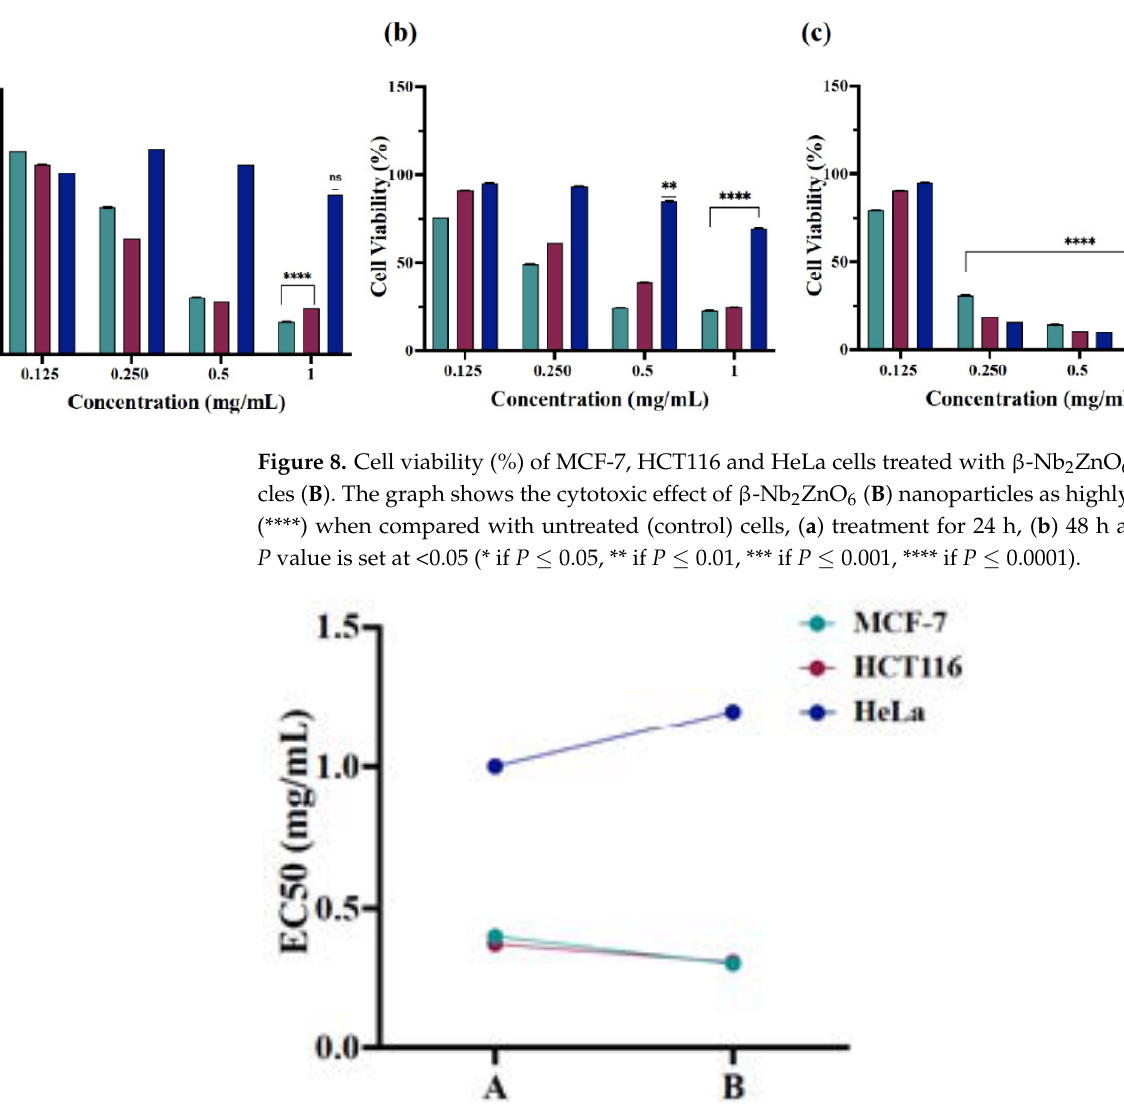
Figure 7. Cell viability (%) of MCF- 7, HCT116 and HeLa cells treated with β -Nb 2 ZnO 6 nanoparti- cles ( A ). The graph shows the cytotoxic effect of β -Nb 2 ZnO 6 nanoparticles ( A ) as highly significant (****) when compared with untreated (control) cells, ( a ) treatment for 24 h, ( b ) 48 h and ( c ) 72 h. P value is set at <0.05 (* if P ≤ 0.05, ** if P ≤ 0.01, *** if P ≤ 0.001, **** if P ≤ 0.0001).